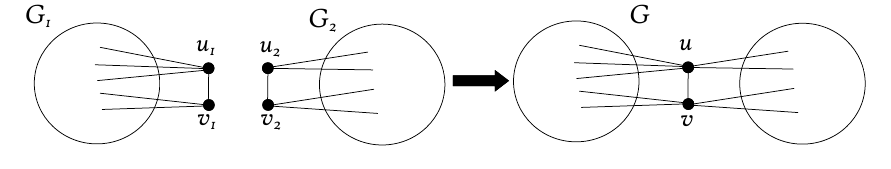
Fig. 2: The edge identification